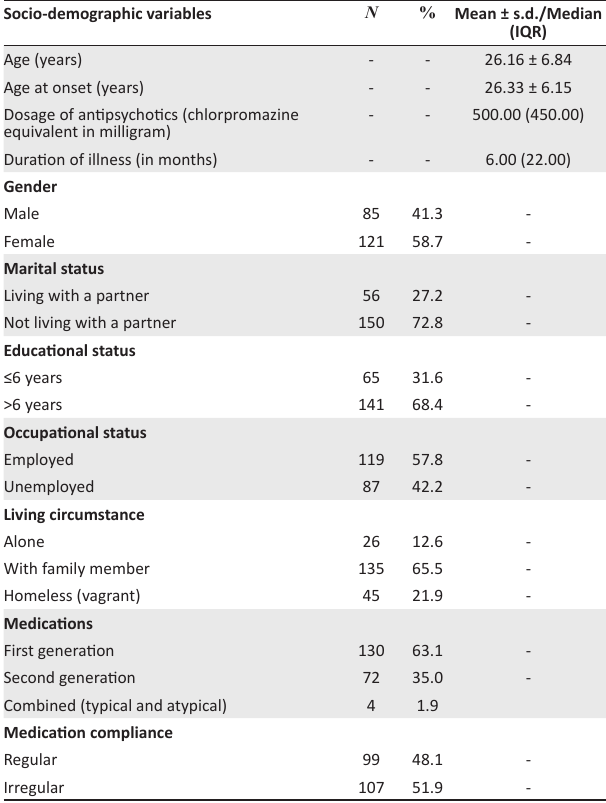
TABLE 1: Socio-demographic and clinical characteristics of the study participants, N = 206. Socio-demographic